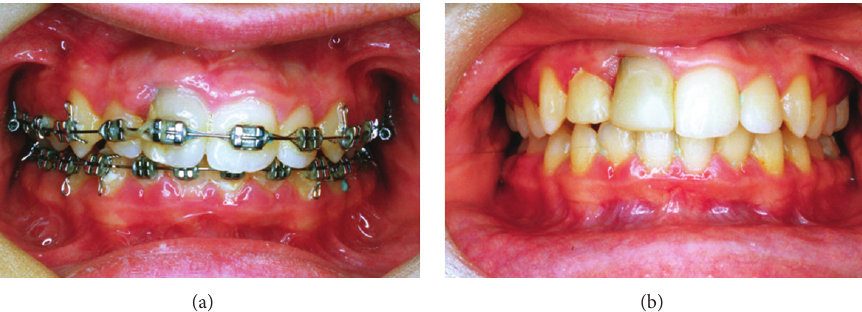
Figure 4: Clinical images. (a) Orthodontic treatment for Class II malocclusion; (b) dental cosmetic treatment of the right maxillary lateral and central